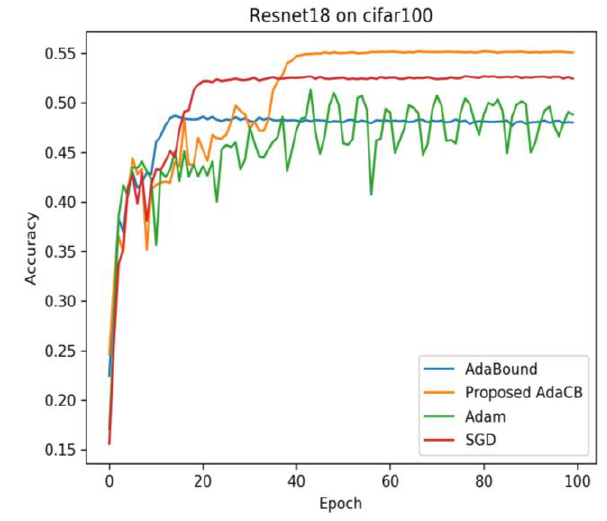
Figure 7. The learning curve of testing accuracy on CIFAR100 under Resnet18. Table 5. The performance of optimizers on cifar10 and cifar100 under Resnet18.